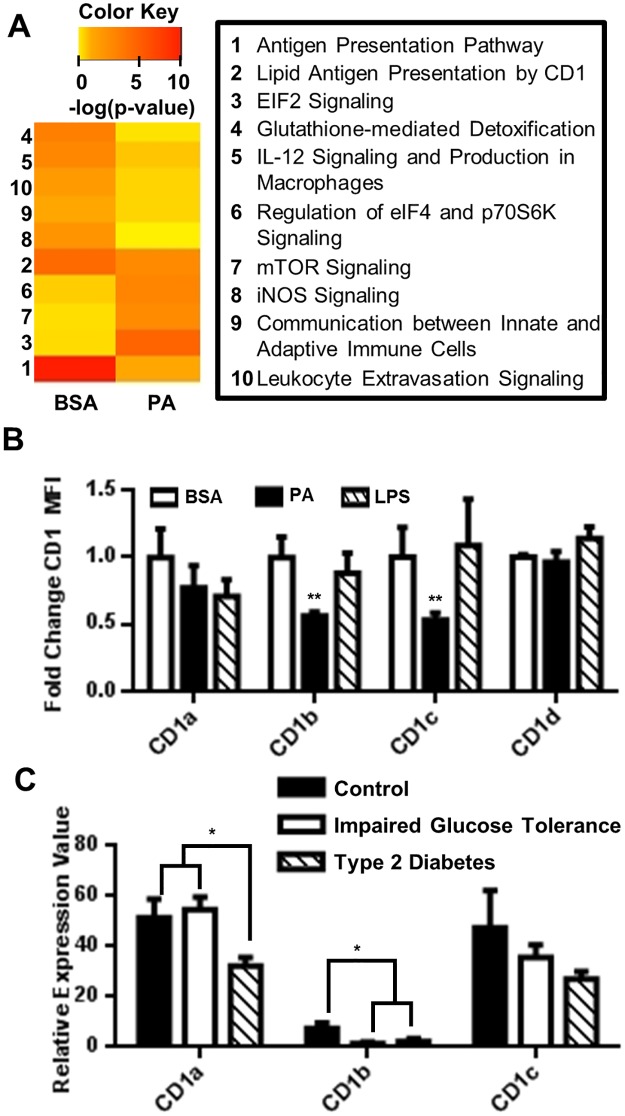
PA downregulates DC expression of CD1.(A) Heat map representing canonical pathways [-log(p-values)] identified in PA-treated MoDCs. Increasing intensity of red color indicates a higher probability that the indicated pathway is regulated by PA. (B) MoDCs were treated with 150μM PA complexed 2:1 with BSA for 24hrs. Following incubation, the cells were stained for surface receptors and analyzed by flow cytometry. The normalized MFI for the indicated markers on CD11chi MoDCs was plotted. N = 3. (C) CD1 downregulation is associated with type 2 diabetes. Analysis of public Geo Expression Omnibus data set (Data Set Record, GDS3963; Series, GSE26168) is presented. mRNA from primary adult blood was analyzed with tiling array by Karolina et.al [43]. (Controls, N = 8), (Impaired fasting glucose, N = 7), (Type 2 Diabetes, N = 9). Statistical analysis was performed using One way ANOVA (** = p<0.01, *** = p<0.001).